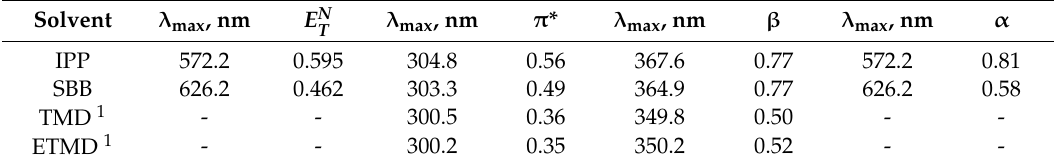
Table 13. The Kamlet-Taft solubility parameters for the renewable diol derivatives.